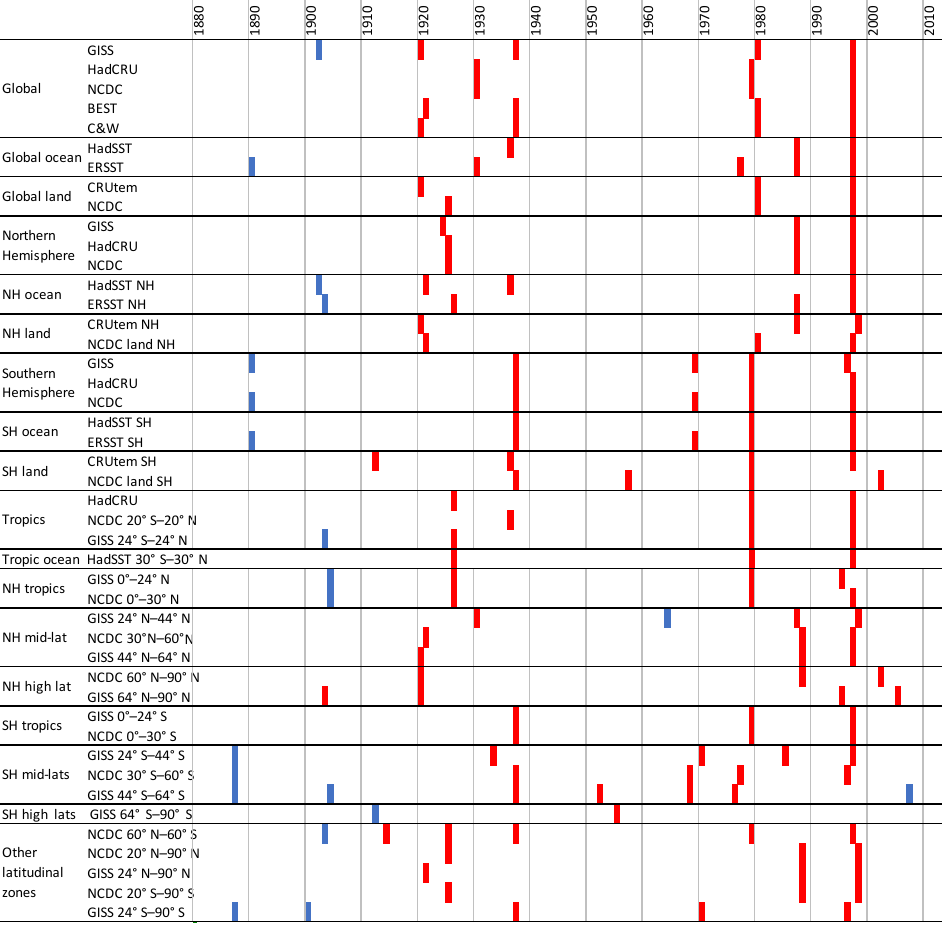
Figure 2. Dates of statistically significant step changes ( p <0.01) in 1880–2014 for a range of mean annual temperature records. Downward steps are blue and upward steps are red. Records are sourced from the Goddard Institute of Space Studies (GISS); Hadley Centre and Climate Research Unit: HadCRU (land and ocean), HadSST (ocean), CRUtem (land); National Climatic Data Center: NCDC (land, land and ocean); ERSST (ocean); Berkeley Earth Surface Temperature (BEST); and Cowtan and Way (C&W). See Supplement for